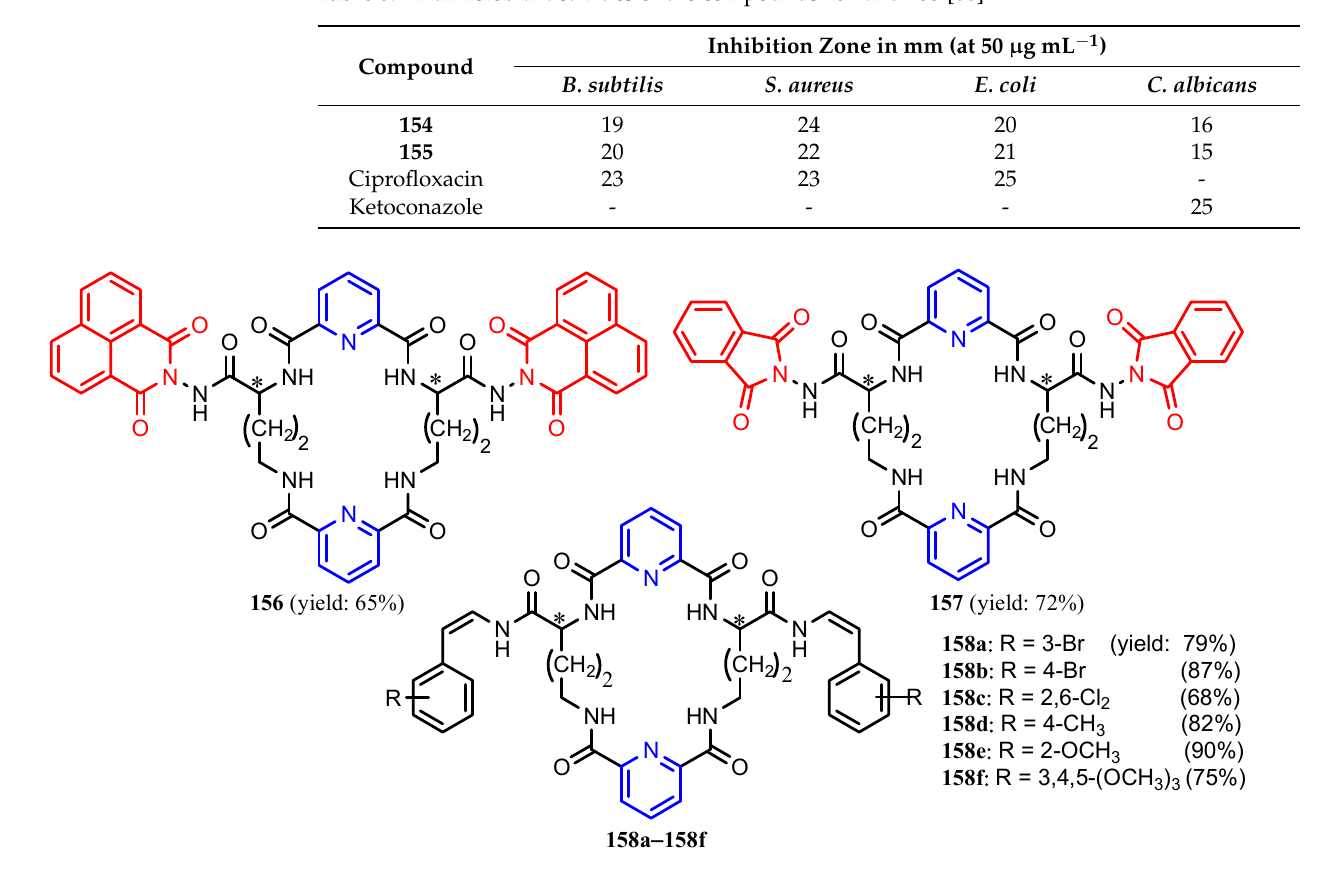
Table 8. Antimicrobial activities of the compounds 154 and 155 [66].